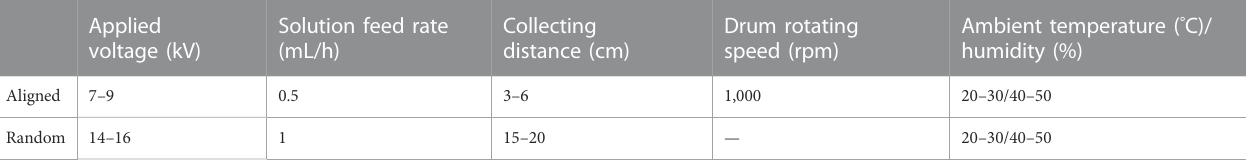
TABLE 1 Parameters used for electrospinning aligned and random fi brous mats. Applied voltage